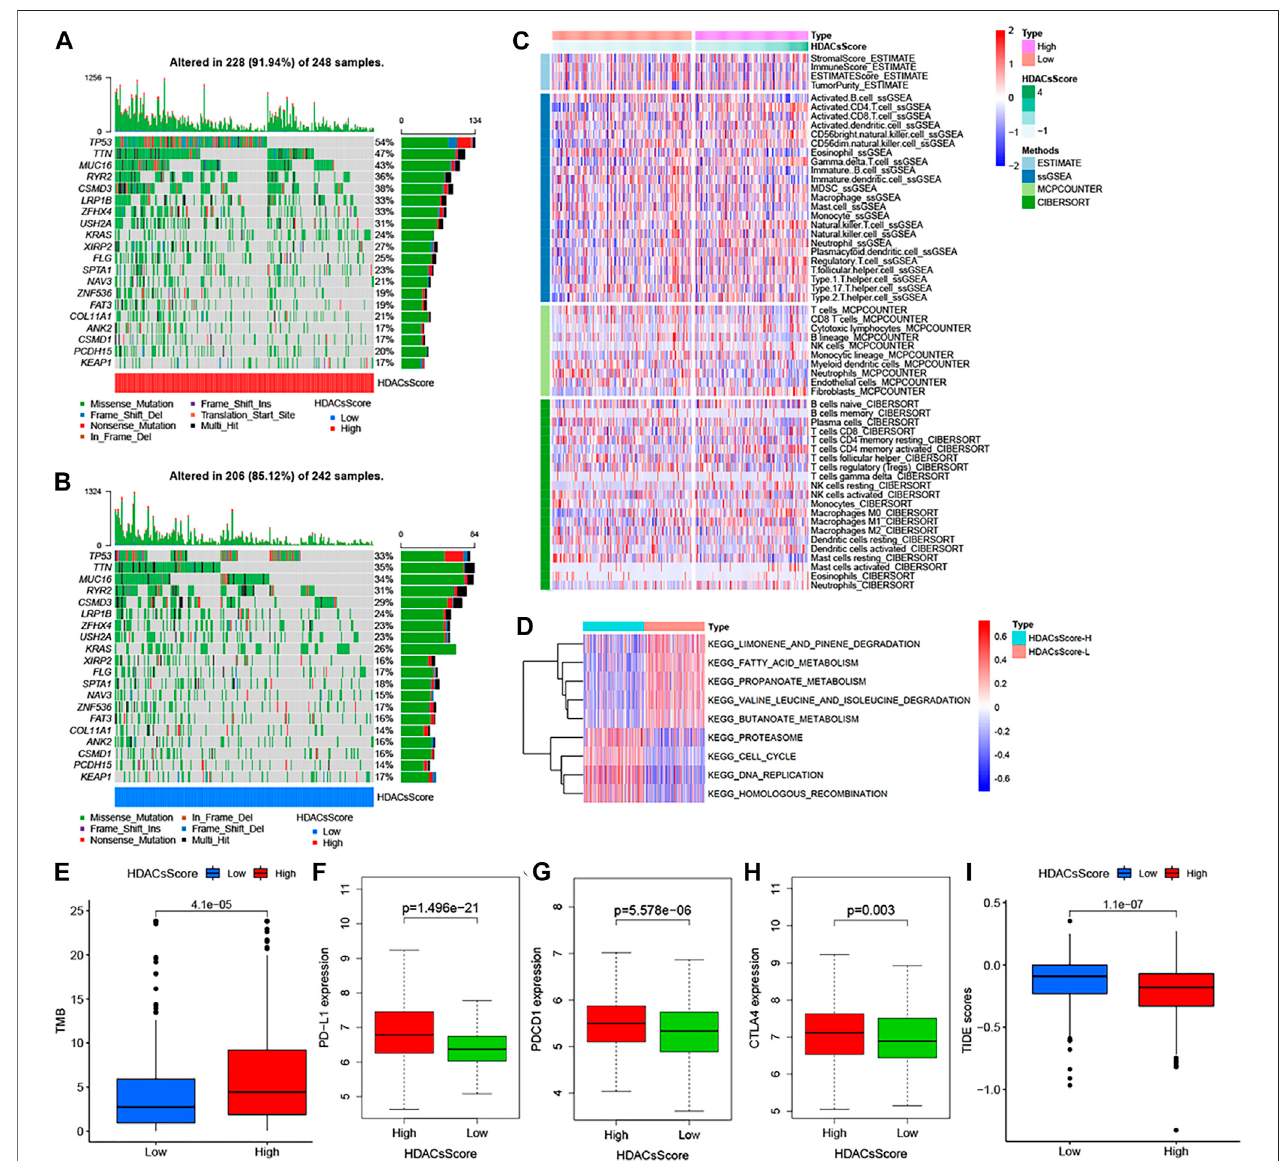
FIGURE 5 | Genetic alteration landscape, immune in fi ltration, and biological characteristics in different HDACsScore subgroups. (A – B) Waterfall plot of tumor somatic mutation established in high- (A) and low- (B) HDACsScore groups. Each column represented individual patients. The upper barplot showed TMB, and the number on the right indicated the mutation frequency in each gene. The right barplot showed the proportion of each variant type. (C) Comparison of tumor immune in fi ltratingcellsbasedonssGSEA, CIBERSORT, andMCPcounteralgorithmsinthehigh-andlow-HDACsScoregroups.Redindicatedthehighin fi ltratinglevelsof immune cells and blue indicated the low in fi ltrating levels. ESTIMATE score, stromal score, immune score, tumor purity, and subtype are also shown below the annotation. (D) GSVA enrichment analysis showing the activation states of biological pathways in high- and low-HDACsScore groups. The Wilcoxon rank sum test revealed signi fi cant difference on TMB (E) , expression of PD-L1 (F) , PDCD1 (G) , CTLA4 (H) , and TIDE score (I) between high- and low-HDACsScore